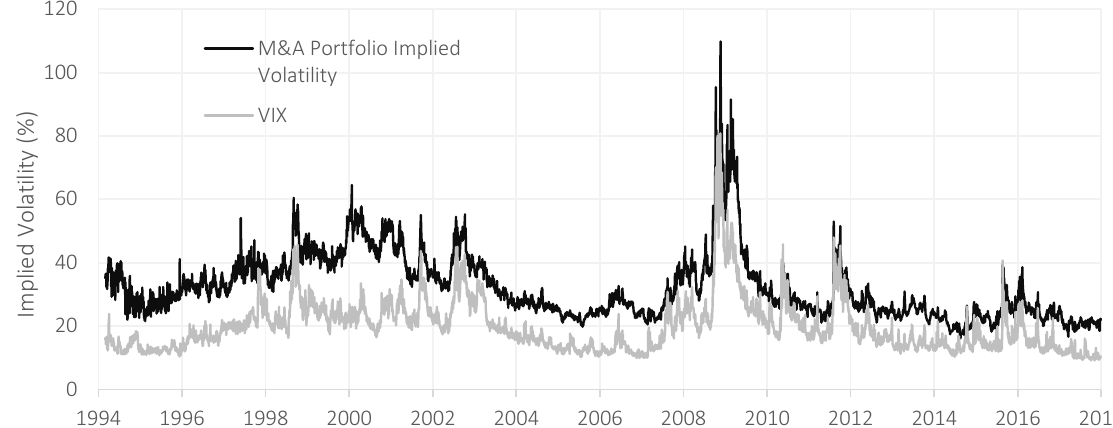
Figure 3. M&A portfolio implied volatility and VIX index